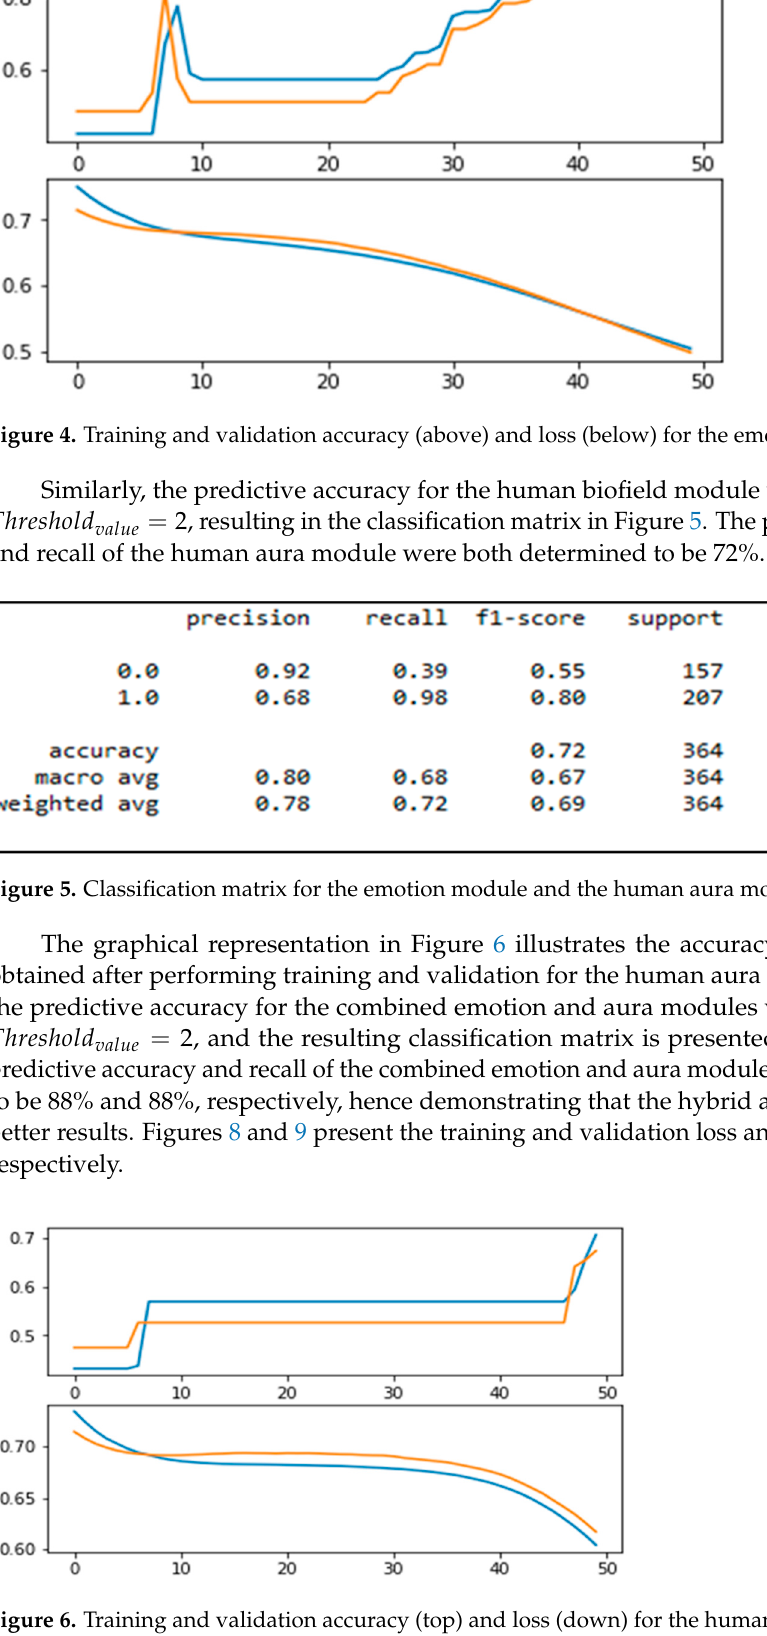
Figure 7. Classification matrix for the emotion and aura modules.